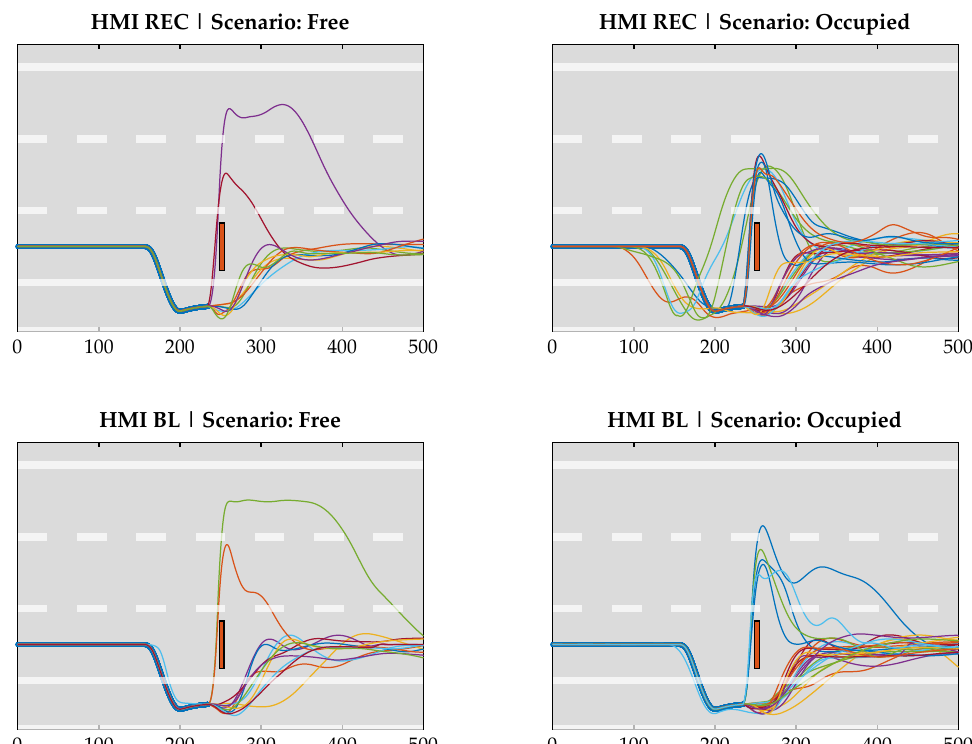
Figure 11. Trajectories of the center of gravity of ego vehicle if there was no intervention or in the case of a standstill maneuver in the shoulder lane. The blue thick line shows the trajectory of the MRM and transition phase starts at 0